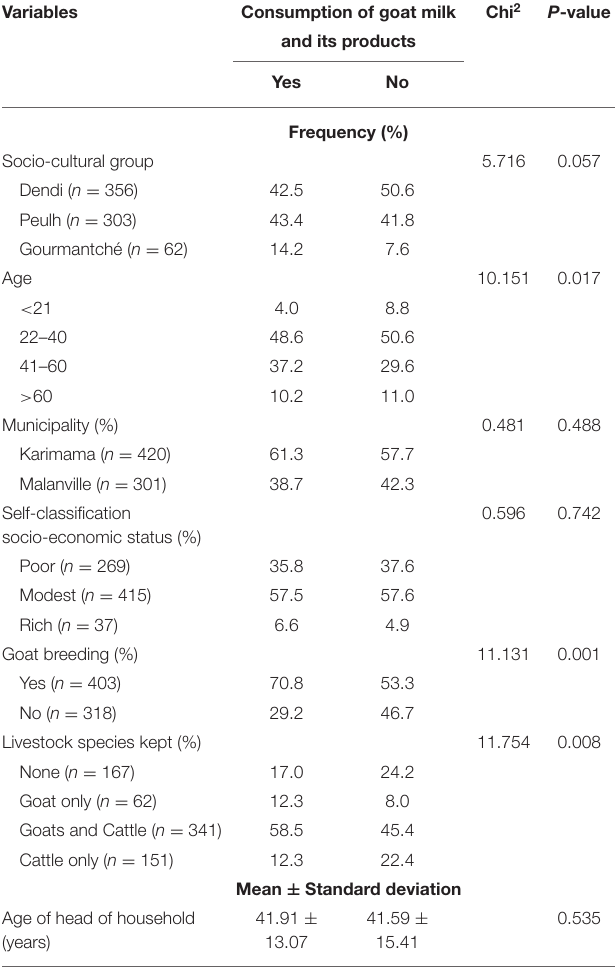
TABLE 4 | Logistic Regression predicting the likelihood of a household to TABLE 3 | Relation between household’s socio-economic characteristics and consume goat milk in Niger Valley of Benin ( n = 7 21). consumption of goat milk in Niger Valley of Benin ( n = 721). Variables Consumption of goat milk Chi 2 P -value Predictor and its products